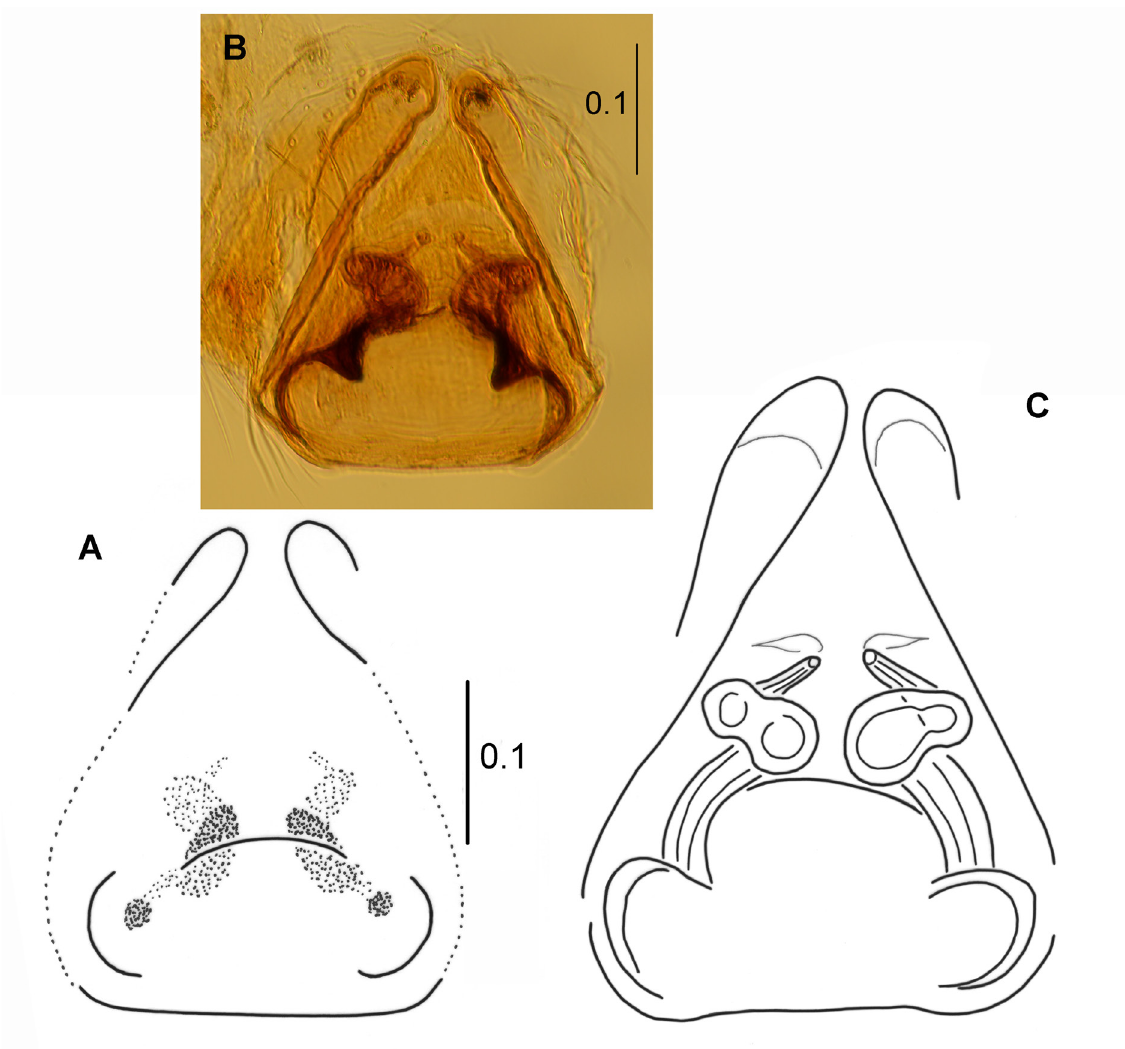
Fig. 17. Heliophanus butemboensis Wesołowska, 1986, ♀ (MNHN). A . Epigyne. B–C . Internal structure of